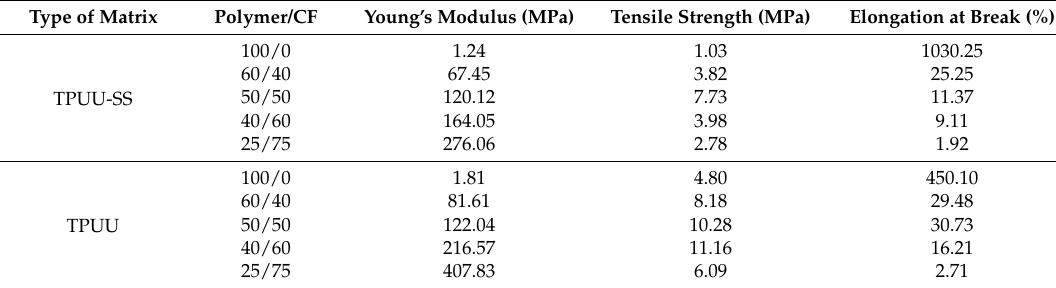
Table 3. Tensile properties of neat polymers and CFs reinforced biocomposites.